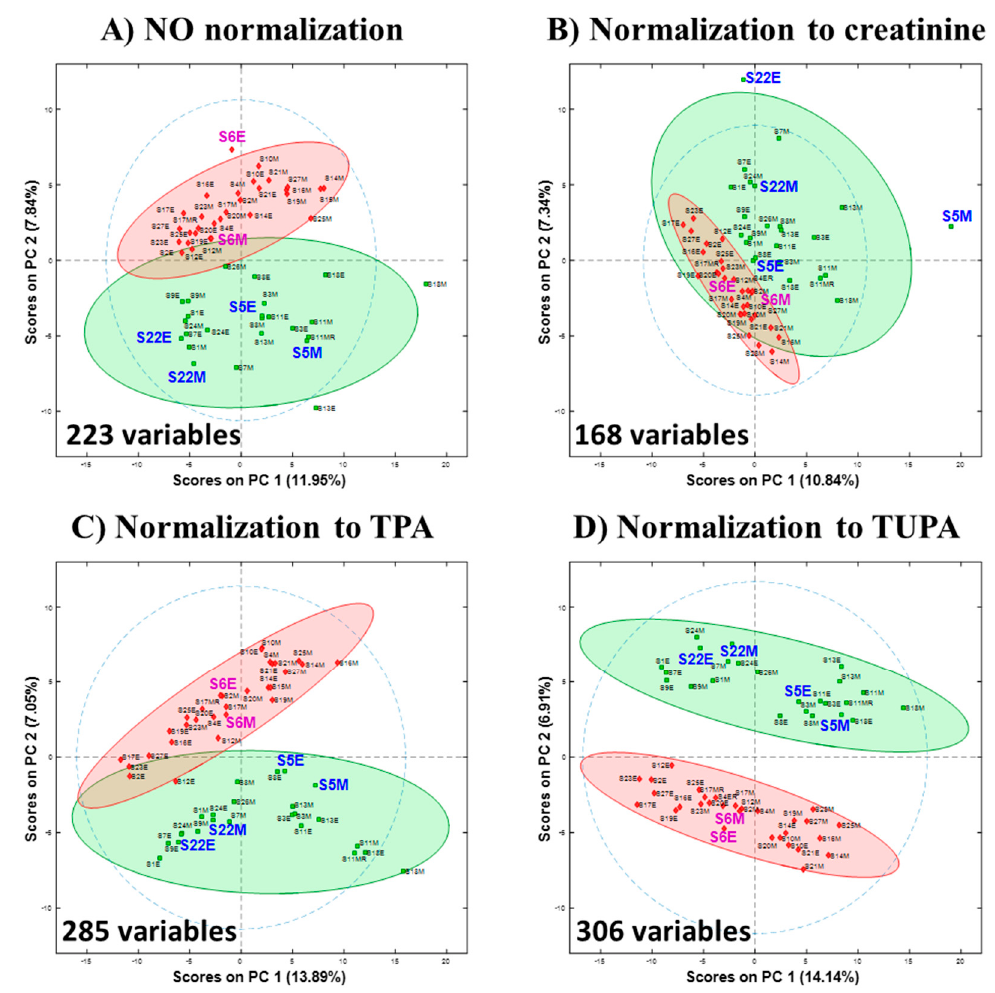
Figure 2. PCA score plots with 95% confidence ellipse for ( A ) without normalization, ( B ) normalized to creatinine concentration, ( C ) normalized to TPA, ( D ) normalization to TUPA. To further demonstrate the need for proper normalization, the variables that were selected to model the data after TUPA normalization (Figure 2D) were used to model the system both without normalization, and with normalization to creatinine. (Figure 3). This was to demonstrate that the separation is not just based on the selected variables, but on the combination of proper normalization of analyte responses and the appropriate choices of variables.